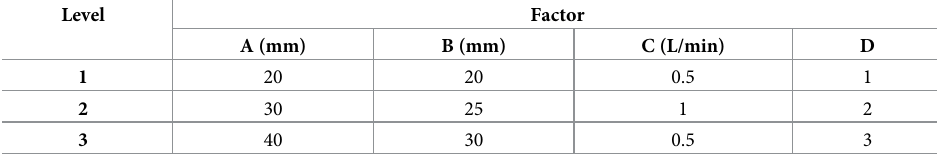
Table 1. Factors and levels for the canine-mimicking nasal cavity.